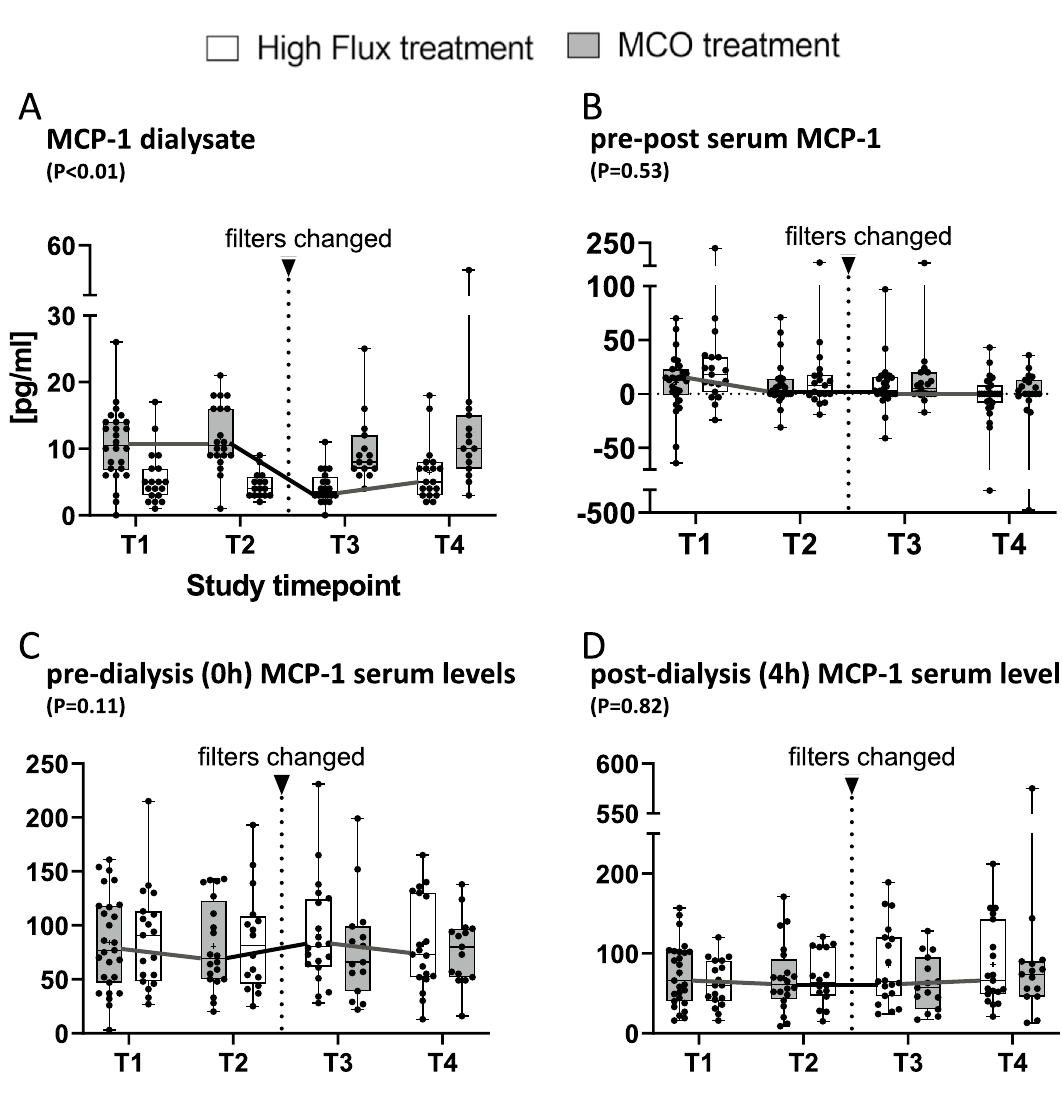
Figure 2. ( A ) Reports mean, and 95%-CIs of dialysate MCP-1 concentrations stratified by treatment (MCO = 1) for all 4 time-points (T1 = Baseline; T2 = after 90 days of treatment with MCO or high flux; T3 = after another 30 days of wash out; T4 = after another days of treatment of high flux or MCO, respectively). ( B ) Δ-values of serum MCP-1 were calculated as: “pre-(0 h)-serum level” minus “post-(4 h)-serum level”. ( C , D ) Pre- and post- hemodialysis MCP-1 serum levels stratified by treatment (MCO = 1) are displayed. Herein, Pre-HD MCP-1 is equivalent to long-term (3 months) effects of MCO versus standard high flux membranes. ( A – D ) Statistical comparison was done using a linear mixed effect model with subject ID (nested in sequence) as random effect. Treatment (MCO = 1), period and sequence were tested as main effects. A P value of < 0.05 was considered statistically significant. MCP-1